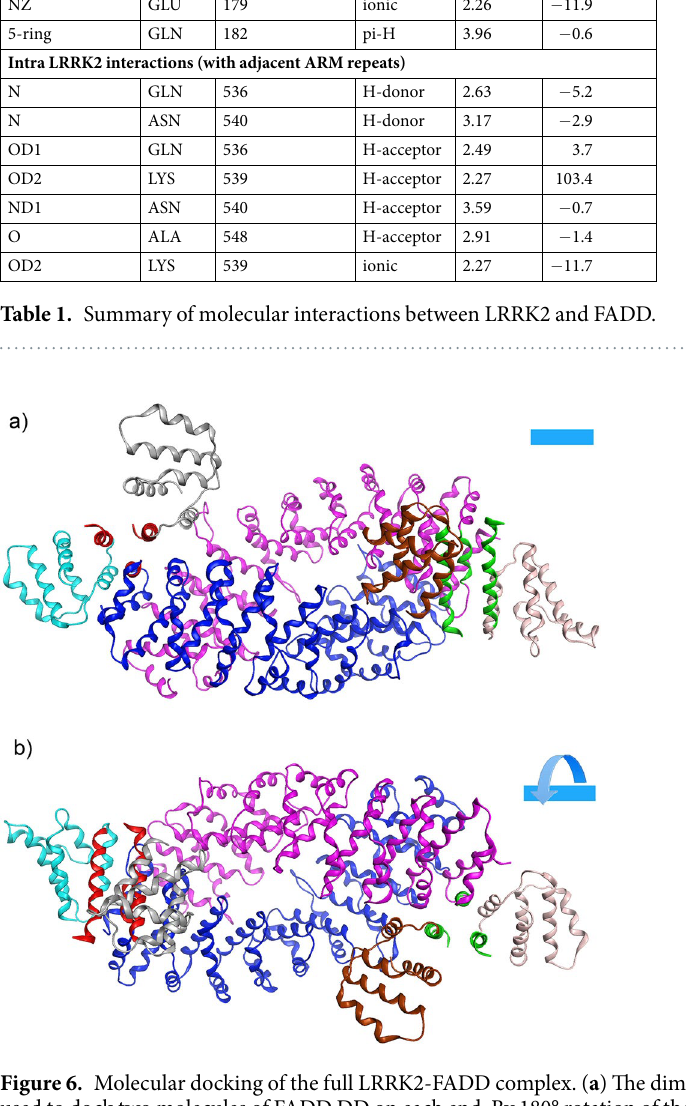
coupled with the biochemical findings suggest that the FADD-interaction motif is located within the 500 to 575 amino acid region of the N-terminal domain of LRRK2. We used the same primary rat cortical neuron model to determine whether prevention of the interaction with (endogenous) neuronal FADD blocks neuronal death induced by full-length mutant LRRK2. As would be predicted, prevention of the interaction between over-expressed mutant LRRK2 and endogenous neuronal FADD by co-expression of the entire N-terminal domain or the smaller N-terminal sub-fragments is neuroprotective (Fig. 10b). Representative images of neurons co-expressing un-tagged mutant LRRK2 together with Flag-tagged N-terminal (ARM) fragments of LRRK2 are shown in Fig. 11. Additional images of mutant LRRK2-expressing neurons co-transfected with NT500 or NT575 are shown in Suppl Fig. 11. Additionally, as expected, we also observed that neuronal death induced by either R1441C or I2020T mutant LRRK2 was also similarly disrupted